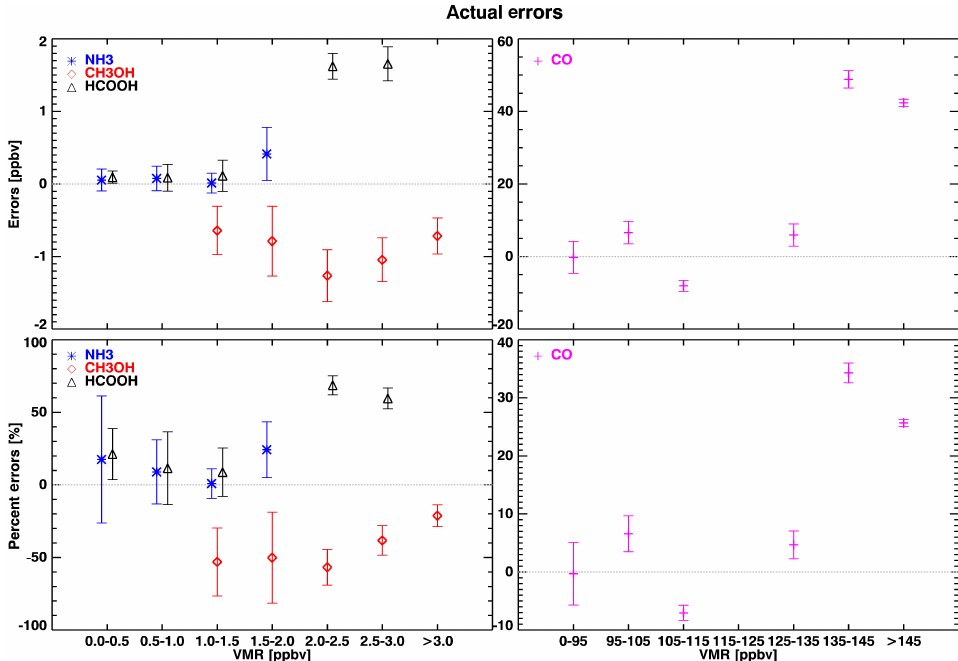
Figure 12. Summary plot of the actual errors (TES/aircraft) from the JOSM comparisons plotted as a function of volume mixing ratio (VMR) for NH 3 , CH 3 OH, HCOOH, and